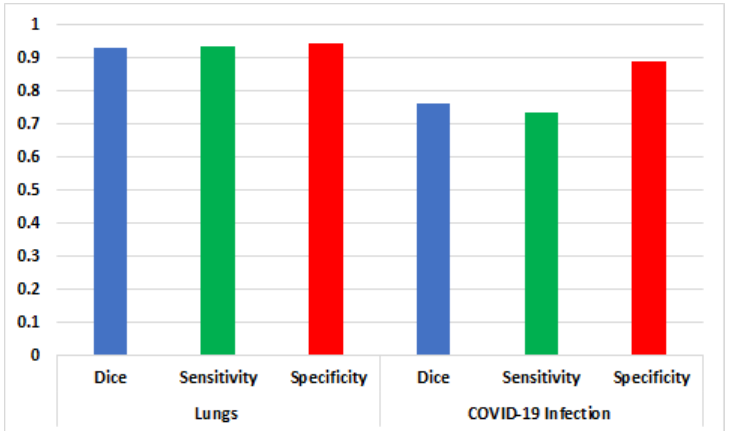
Figure 10. Average values of the Dice similarity coefficient, sensitivity and specificity